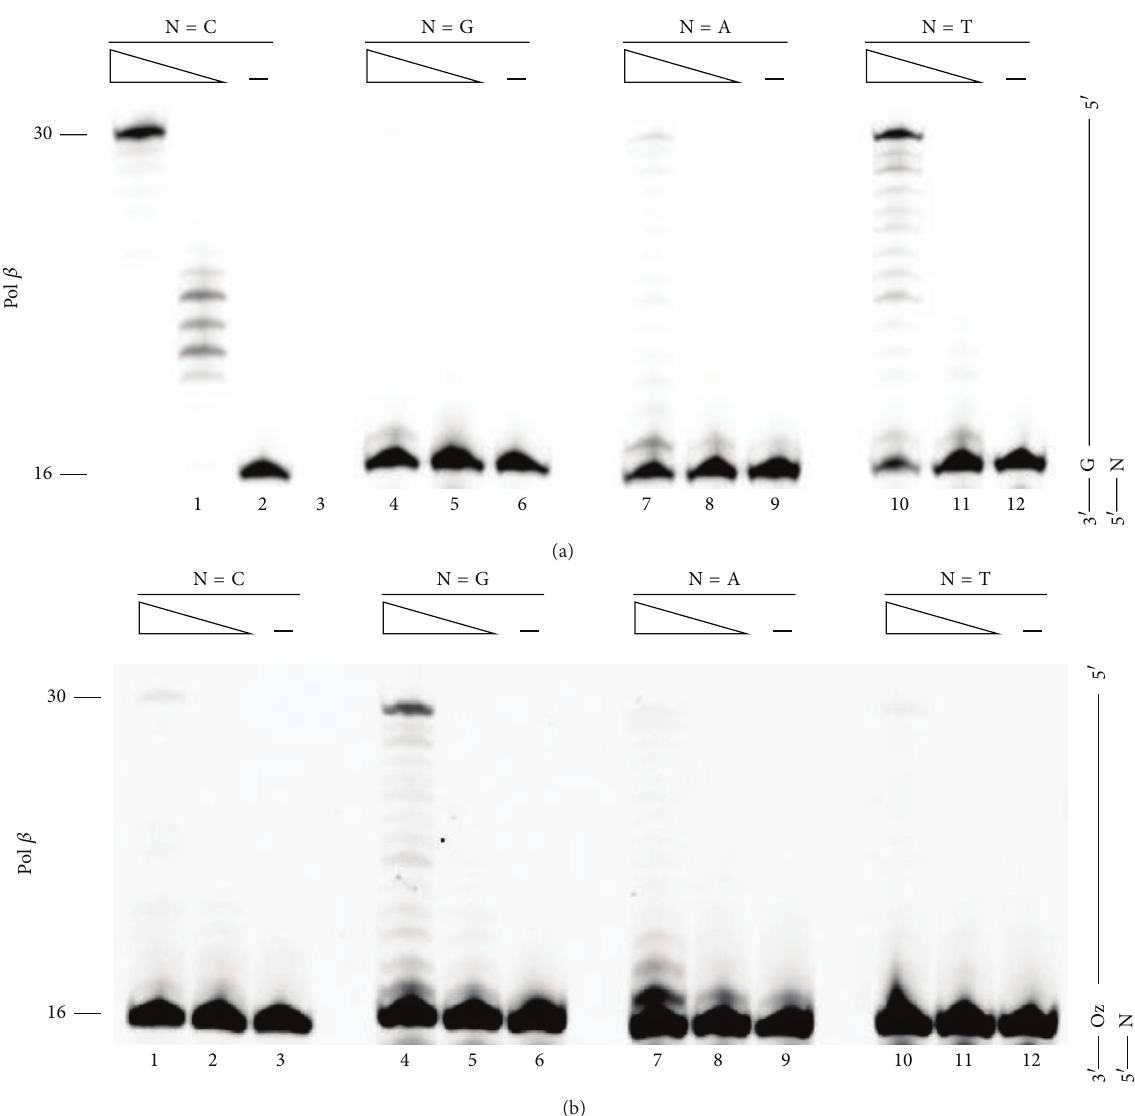
Figure 2: Extension from primer ends by Pol 𝛽 . Each primer contained a different nucleotide at the 3 󸀠 end (indicated by N, where N was C, G, A, or T in lanes 1–3, 4–6, 7–9, and 8–12, resp.) opposite G (a) or Oz (b). The amount of Pol 𝛽 was 25mU in lanes 1, 4, 7, and 10 or 2.5 mU in lanes 2, 5, 8, and